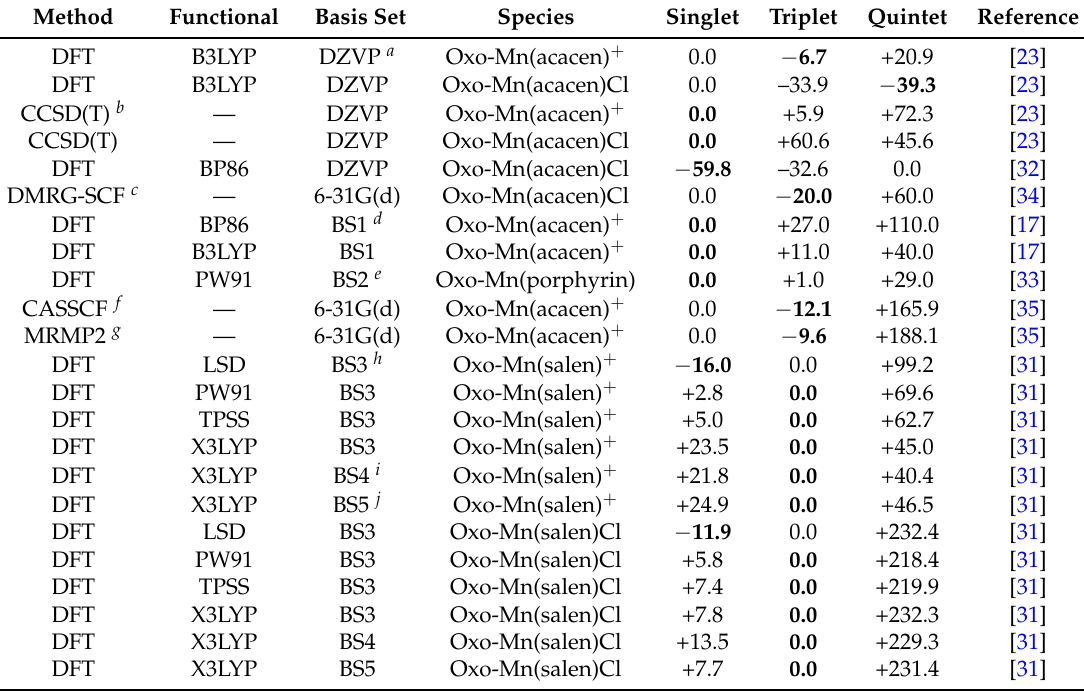
Table 3. Relative gas-phase energies (in kJ · mol –1 ) of the singlet, triplet and quintet states of oxo-Mn complexes. The ground state in each entry is highlighted in